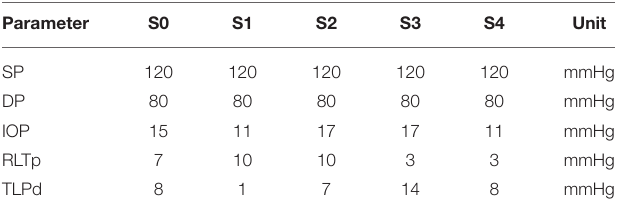
TABLE 1 | Values of systolic blood pressure (SP), diastolic blood pressure (DP), intraocular pressure (IOP), retrolaminar tissue pressure (RLTp), and translaminar pressure difference (TLPd) for the 5 virtual subjects (S0, S1, S2, S3, S4) considered in this